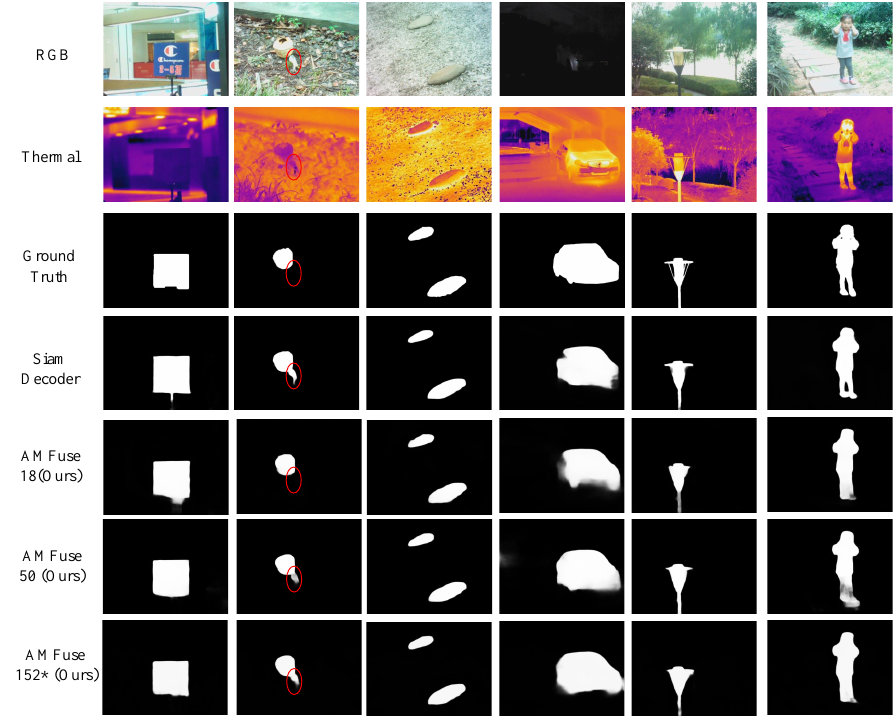
Figure 10. The sample qualitative demonstrations of RGBT multi-spectral SOD. We select 6 RGBT image pairs with diverse challenges to compare the quality of the predicted SOD